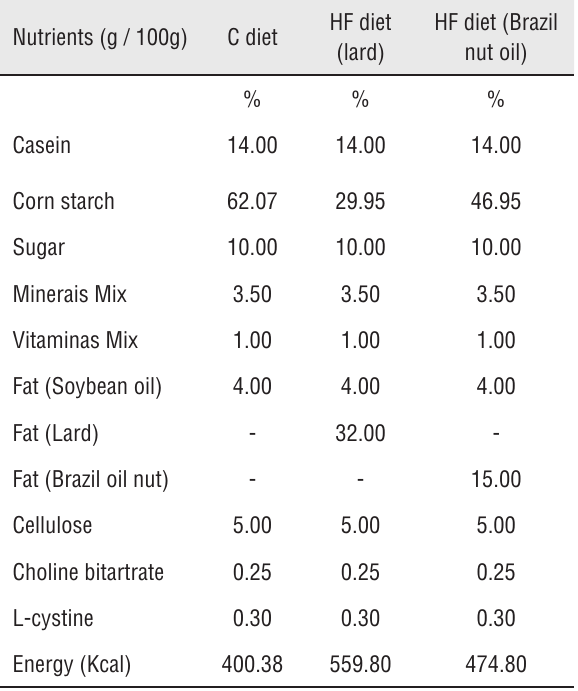
Table 1 - composition of experimental diets.